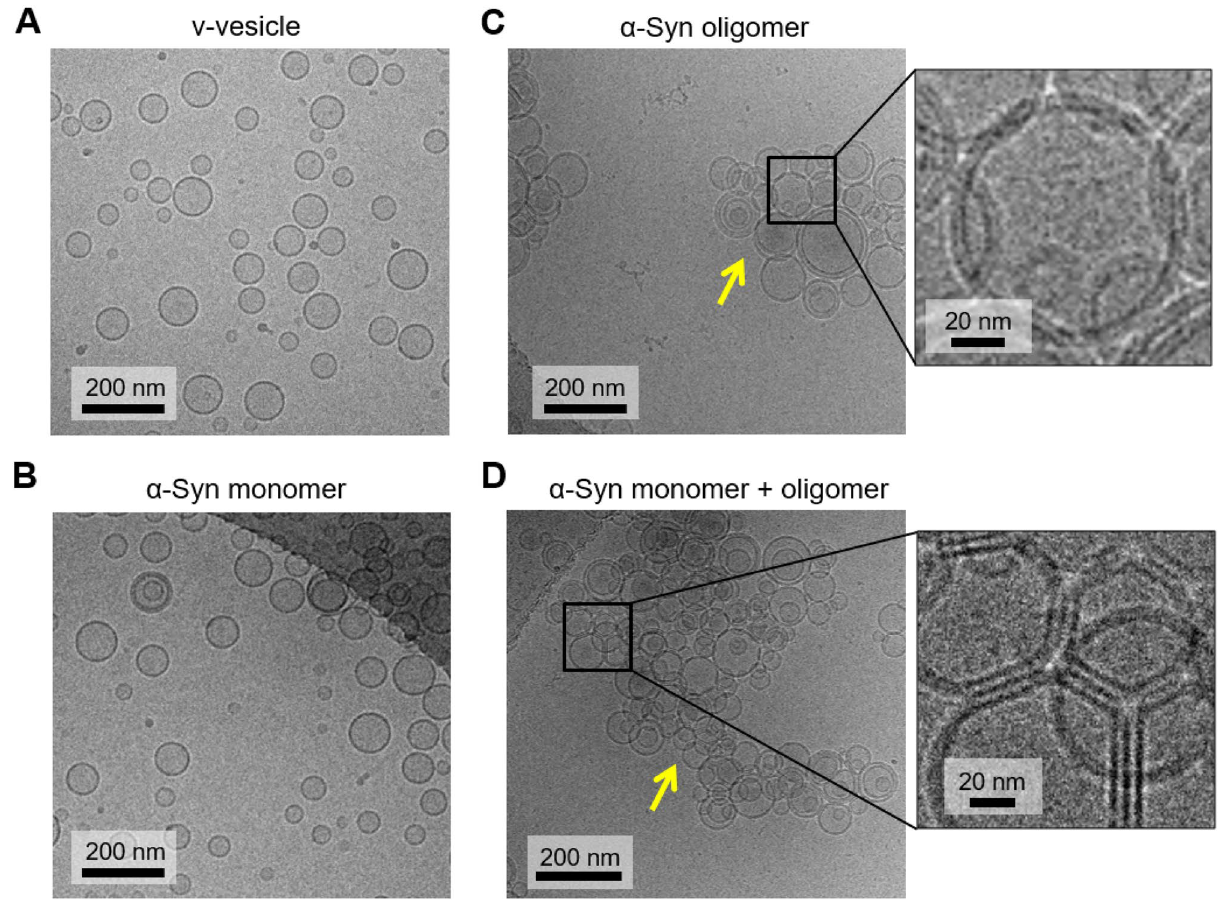
Figure 2. Clustering of v-vesicles by α-Syn oligomers. ( A ) Representative image of v-vesicles without α-Syn. ( B ) v-Vesicles in the presence of α-Syn monomer. The molar ratio of lipid/α-Syn monomers was 10:1 (5 μM: 0.5 μM.) The dark region is the holey carbon grid. ( C ) v-Vesicles in the presence of α-Syn oligomers. The molar ratio of lipid/α-Syn oligomers was 200:1. Clustering of v-vesicles was observed (the yellow arrowhead). ( D ) v-Vesicles treated with both α-Syn monomer and oligomers. The molar ratio of lipid/α-Syn oligomers/α-Syn monomers was 200:1:20. The yellow arrowhead points to large clusters of the vesicles. The vesicle cluster was significantly larger than that observed in ( C ). The enlarged image shows the locally flat and thickened adhesion regions between vesicles, which are not observed in ( C ). All images were edited by Microsoft Powerpoint professional plus 2019